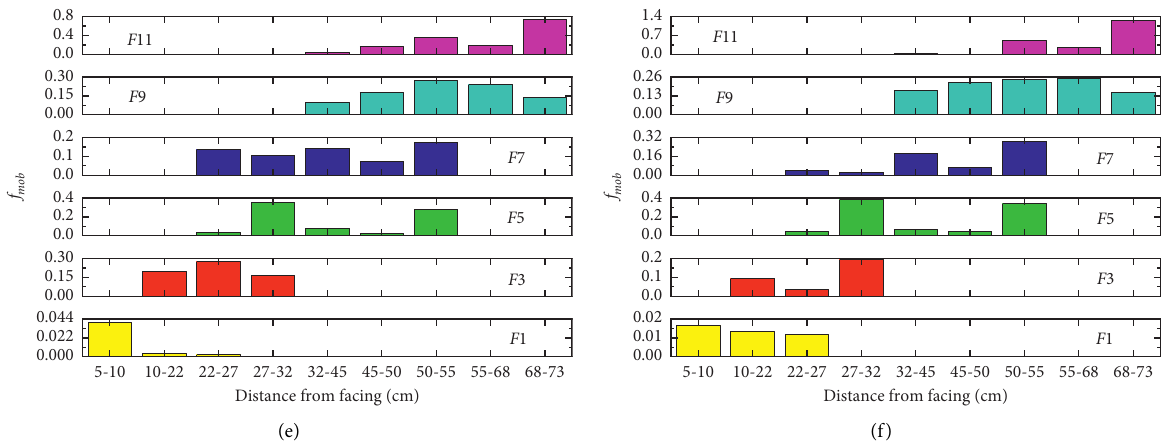
Figure 18: Graphs of the friction coefficients (scaled factor: 1/4): (a) WL 0.1 g, (b) WL 0.2g, (c) WL 0.4g, (d) WL 0.6 g, (e) WL 0.8 g, and (f) WL